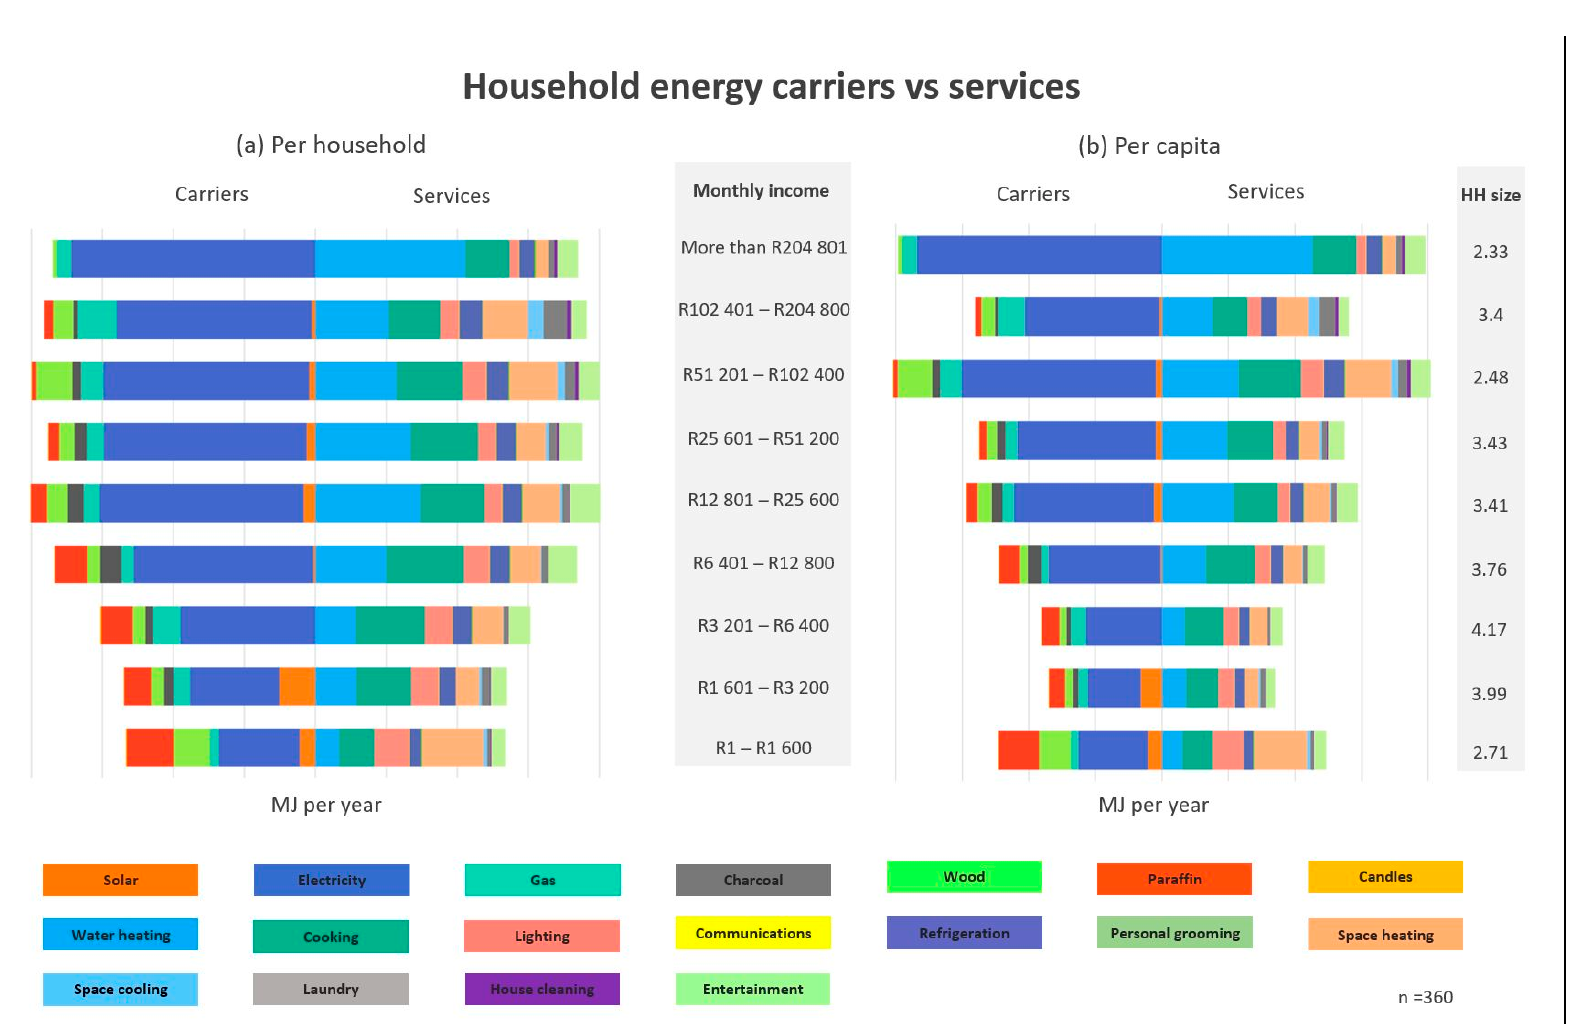
Figure 6. Household energy consumption categorized into carriers and services.